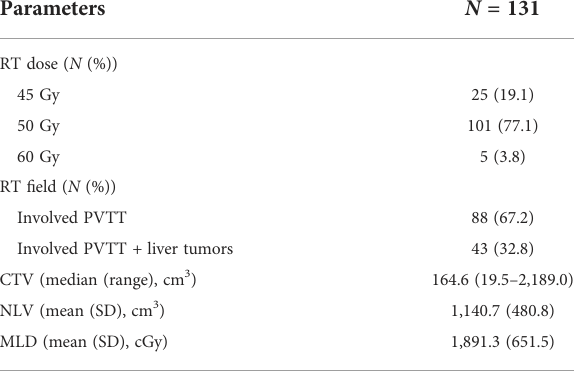
cohort (Figure 3). The rad-score formula was GLRLM_HGRE